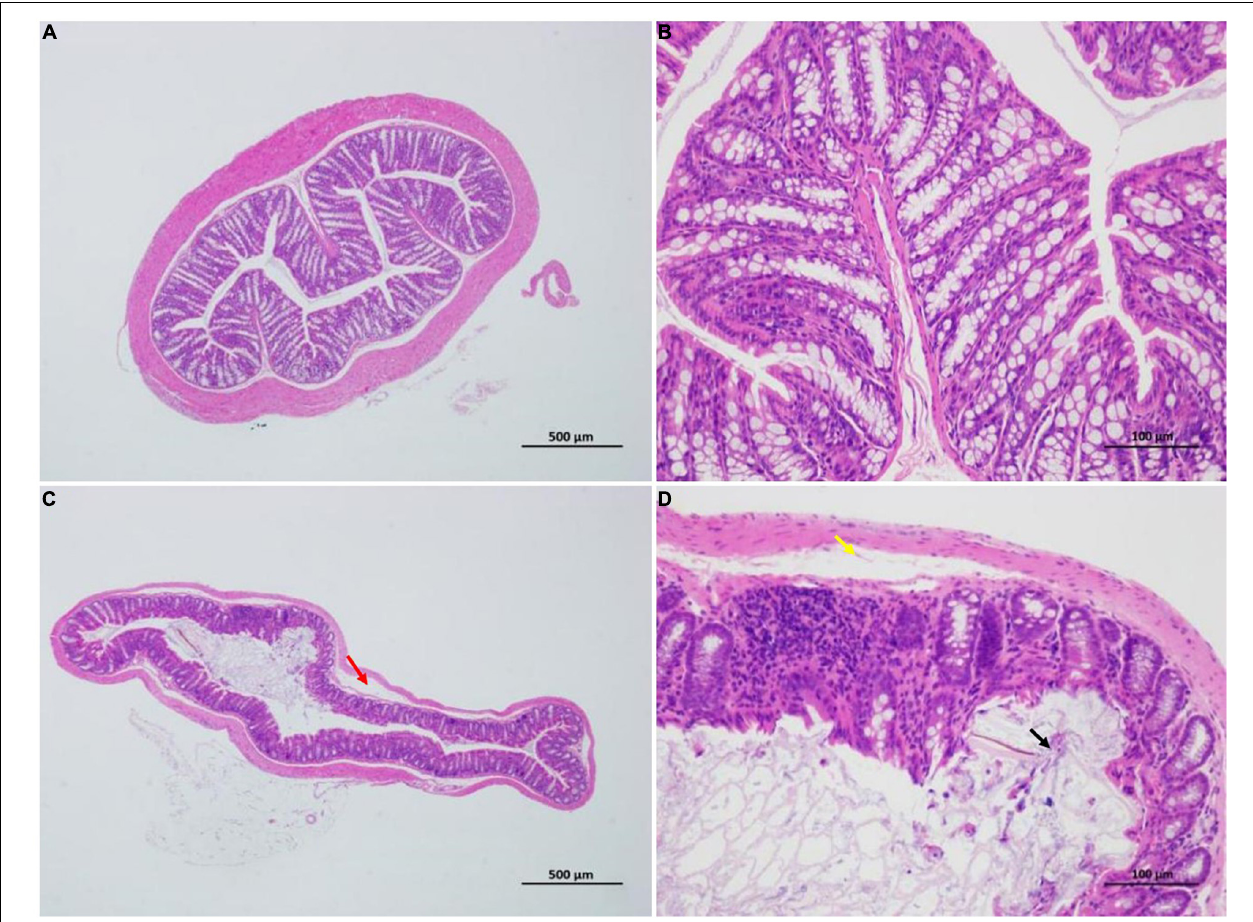
FIGURE 5 | Effect of HFCS on the colon pathology of mice ( n = 8). Control group (A,B) ; distinct structure of circular folds, intact intestinal epithelium (simple columnar epithelium) in the mucosal layer, epithelial cells with a normal morphological structure, abundant intestinal glands in lamina propria, relatively high number of goblet cells, uniformly stained muscular layer, orderly arranged muscular fibers with normal morphological structure, and no apparent signs of inflammation. In summary, the control group was rated 0 (A,B) . HFCS group (C,D) ; minor localized shedding of epithelial cells, massive epithelial lifting down the sides of villi (black arrow) in the mucosal layer, localized focal lymphocytic infiltration, sections with extension of the subepithelial space and moderate lifting of the epithelial layer from the lamina propria (yellow arrow) in the lamina propria, mild localized edema in the submucosa, and loosely arranged connective tissues (red arrow). Therefore, HFCS group (C,D) received a score of